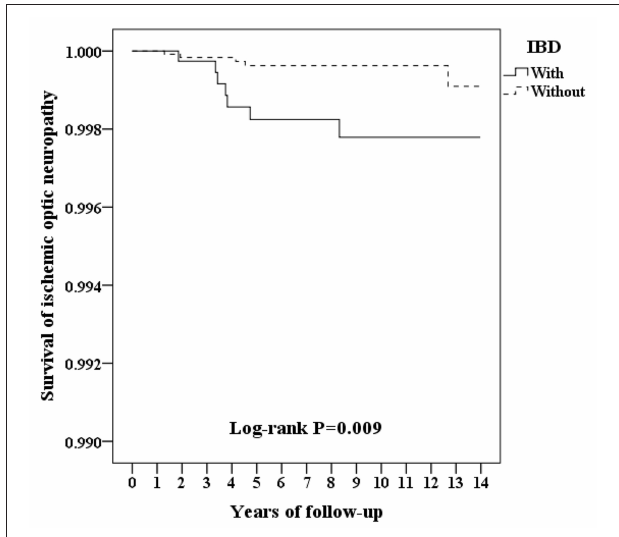
FIGURE 2 | Kaplan–Meier survival curve for ischemic optic neuropathy in patients with and without